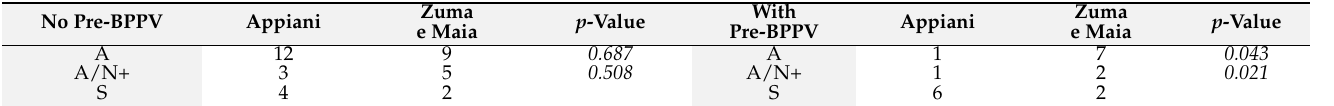
Table 2. Summary of outcomes after the repositioning maneuver in each group of patients with or without previous episodes of BPPV.